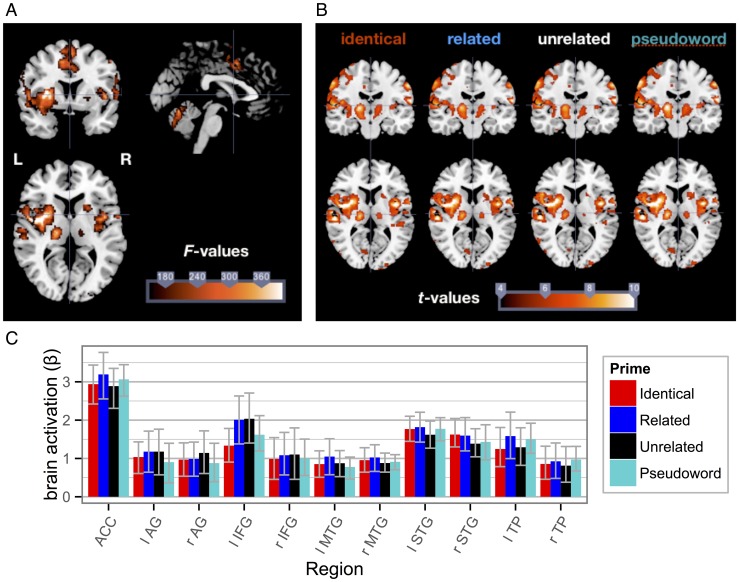
Results from the fMRI analysis.a) Coronal, sagittal and axial view for the whole-head contrast of the effect of stimulus presentation against the implicit baseline. b) Whole-head contrasts of the individual priming conditions against the implicit baseline in coronal and axial views (visualizations correspond to p<.0001 and below). c) Mean activations and bootstrapped 95% confidence intervals for selected brain regions, plotted by condition. Note: l = left, r = right, ACC = anterior cingulate gyrus, AG = angular gyrus, IFG = inferior frontal gyrus, MTG = middle temporal gyrus, STG = superior temporal gyrus, TP = temporal pole.